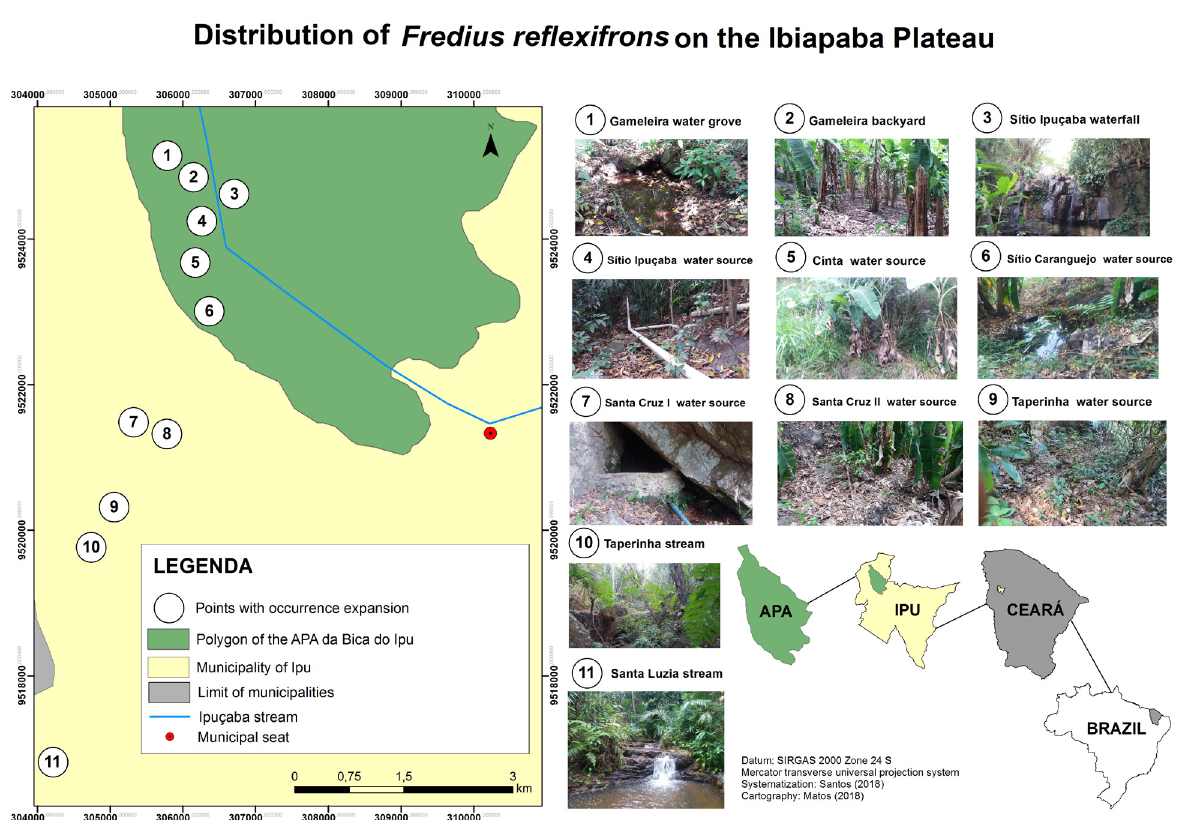
Figure 1. Sites with occurrence of Fredius reflexifrons on the Planalto da